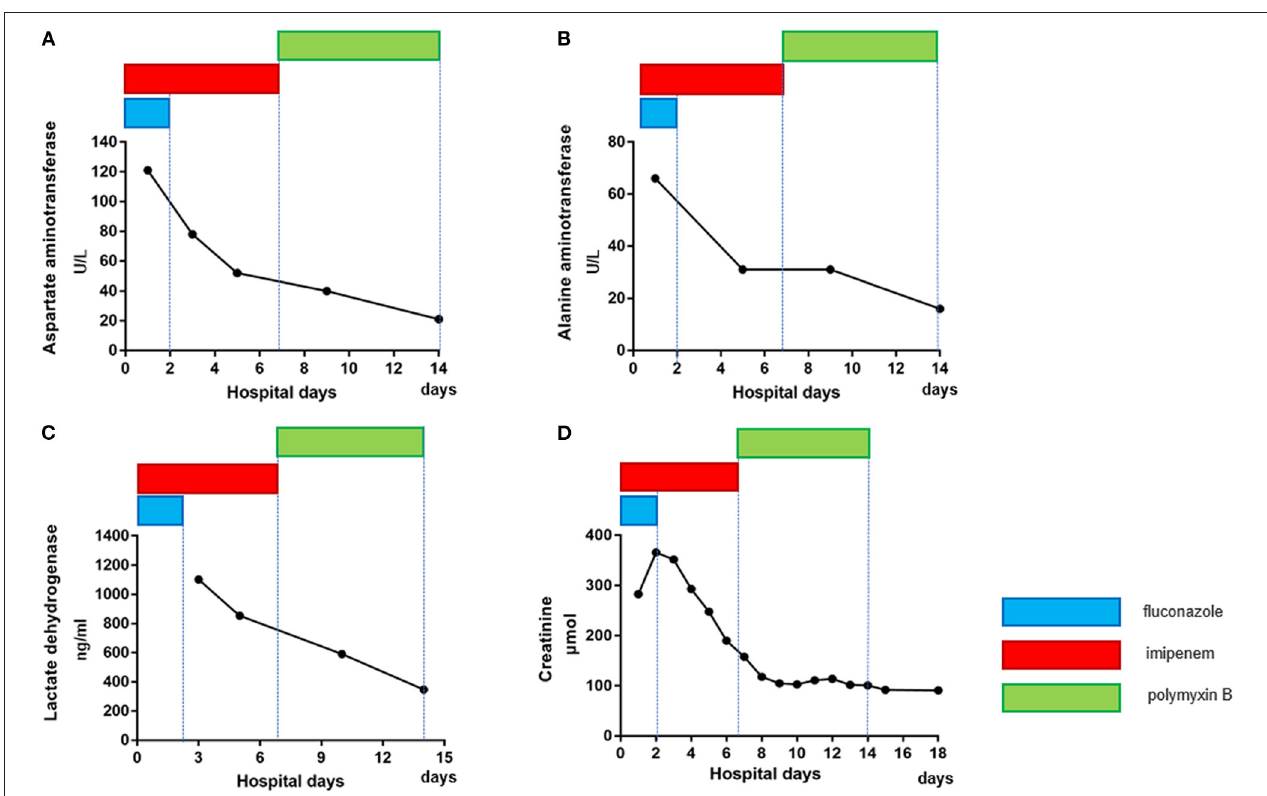
FIGURE 4 | Dynamic changes in liver and kidney function in the patient after admission. After appropriate treatment, the aspartate aminotransferase (A) , alanine aminotransferase (B) , lactate dehydrogenase (C) and creatinine (D) levels of the patient gradually returned to normal (different colors represent different medications, and the length of the lines represents the duration of treatment with the